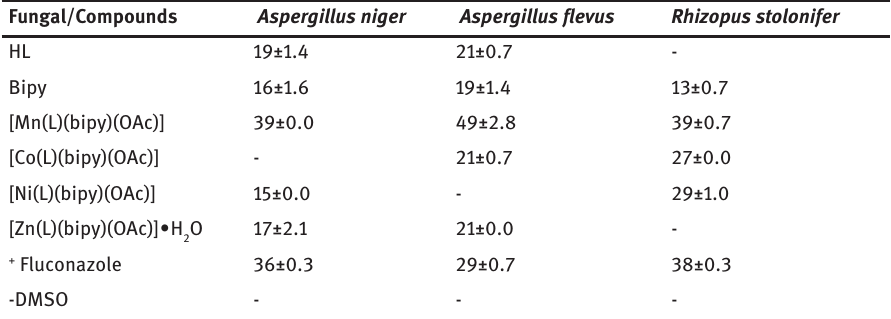
Table 5: Antifungal result for ligand ( HL ) and the metal(II) complexes.